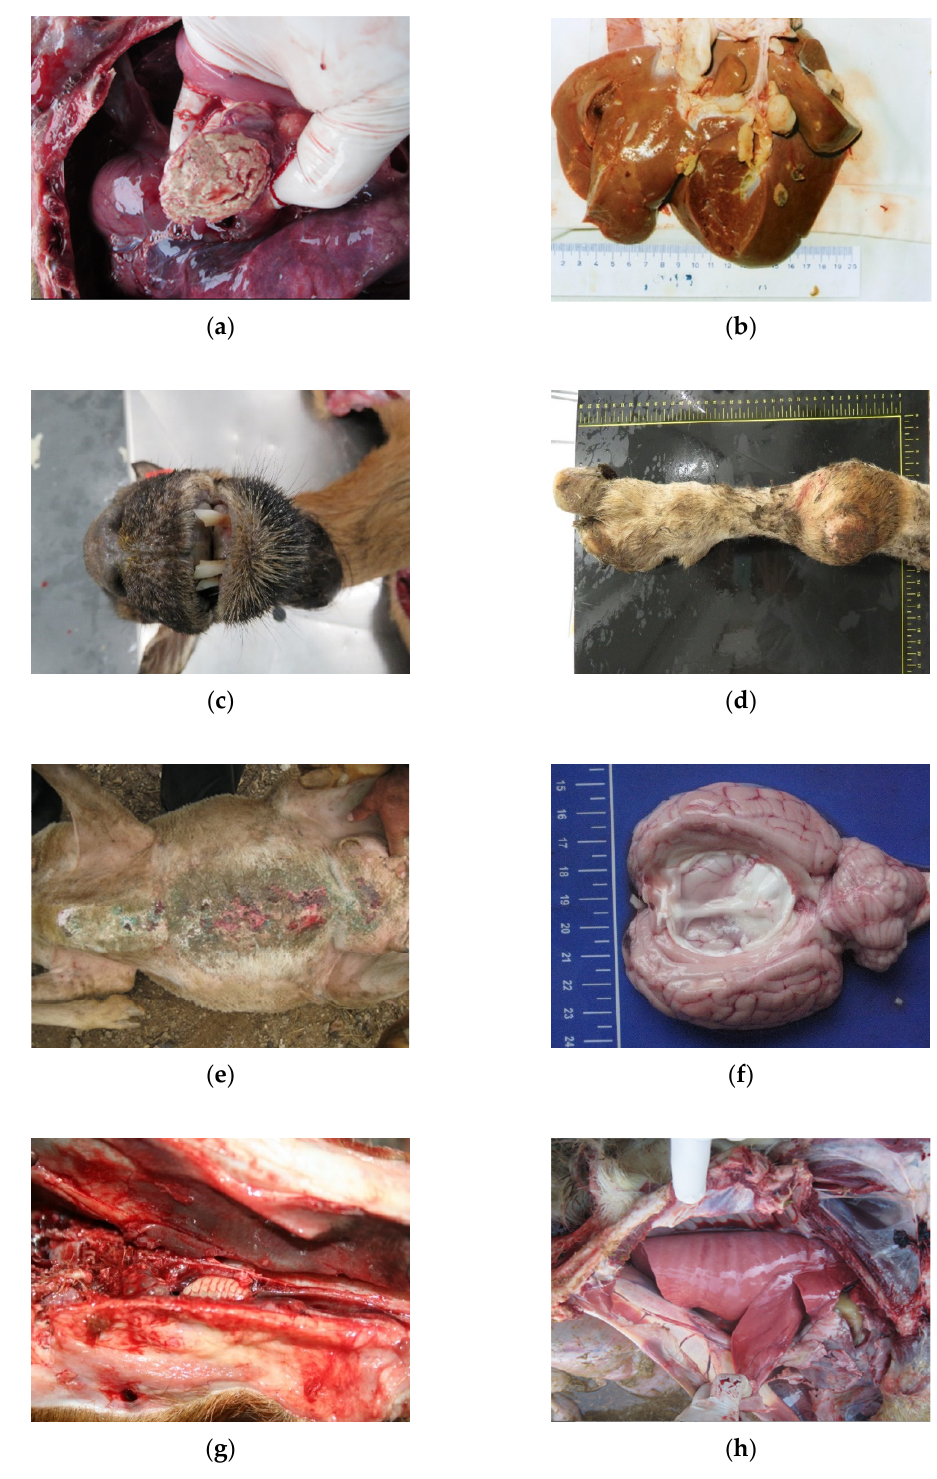
Figure 5. ( a ) Pseudotuberculosis; ( b ) Liver fluke; ( c ) Sore mouth; ( d ) Locomotor problems; ( e ) Scabies; ( f ) Cenurosis; ( g ) Oestrosis; ( h ) Maedi-Visna.